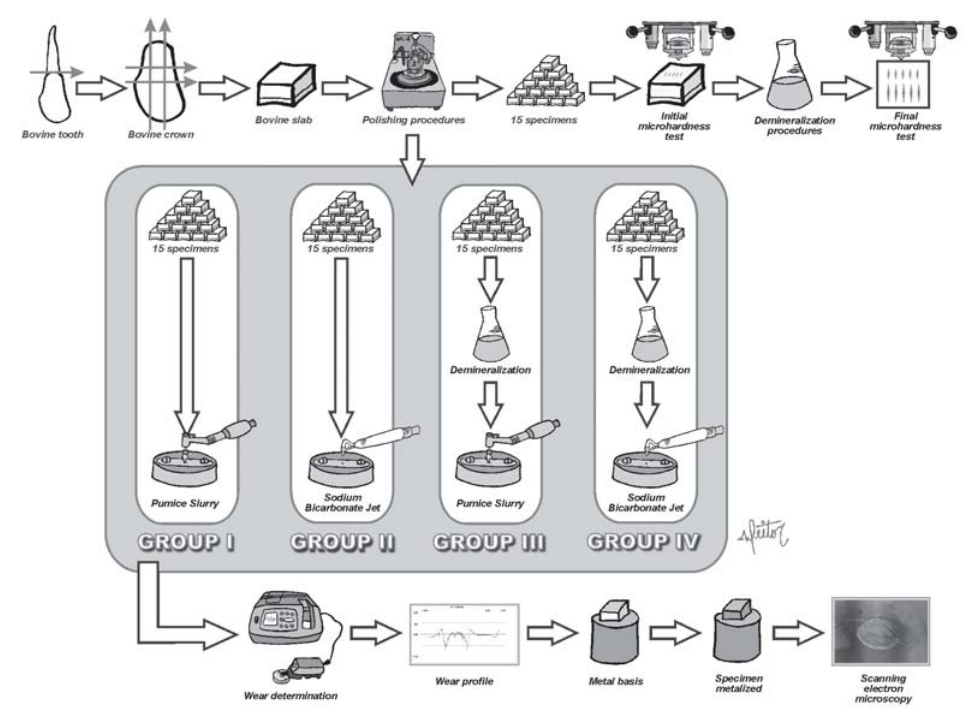
FIGURE 1- Flowchart illustrating the study